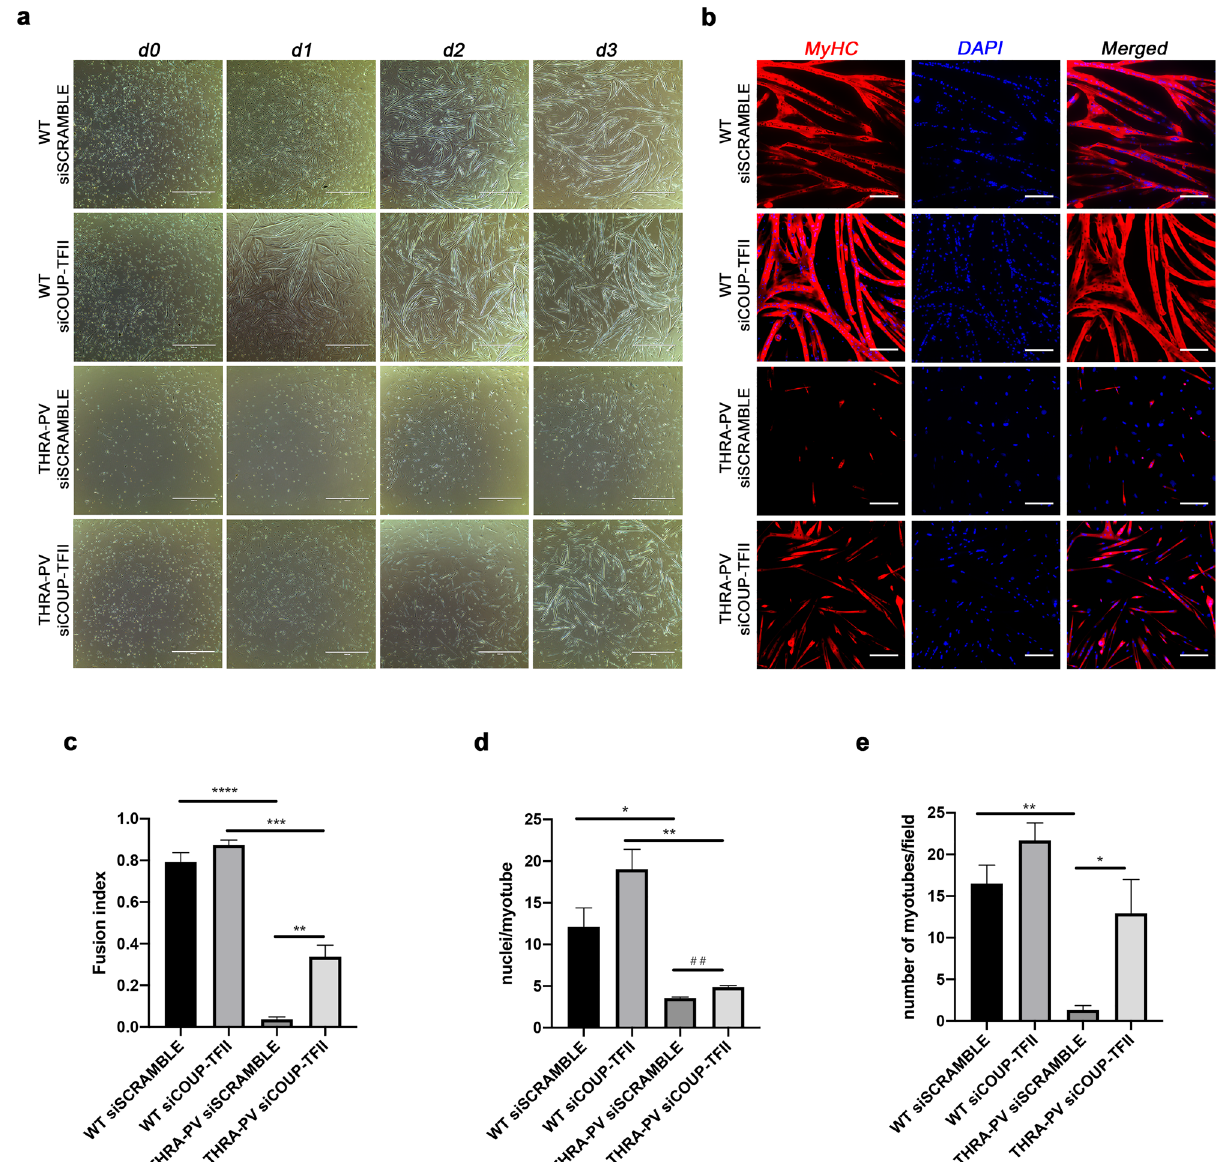
Figure 3. Knockdown of COUP-TFII in THRA-PV myoblasts improves myoblast differentiation. ( a ) Phase contrast images of myogenic differentiation of WT and THRA-PV myoblasts transfected with a scramble (siSCRAMBLE) siRNA or with a siRNA for COUP-TFII (siCOUP-TFII) before (d0) and after 1 (d1), 2 (d2) and 3 (d3) days of induction. Scale bar = 1000 µm ( b ) Immunostaining for Myosin heavy chain (MyHC) three days after induction of differentiation of WT and THRA-PV myoblasts transfected with a scramble (siSCRAMBLE) siRNA or an siRNA for COUP-TFII (siCOUP-TFII). MyHC in red, DAPI in blue. Scale bar = 200 µm ( c ) Fusion index, ( d ) number of nuclei per myotube and ( e ) number of myotube per field for control (siSCRAMBLE) and COUP-TFII silenced (siCOUP-TFII) in primary myoblasts from WT and THRA-PV mice three days after induction of differentiation. Data are shown as mean ± SEM, n = 3. One-way ANOVA * p < 0.05, ** p < 0.01, *** p < 0.001, **** p < 0.0001. Student’s t Test ## p <